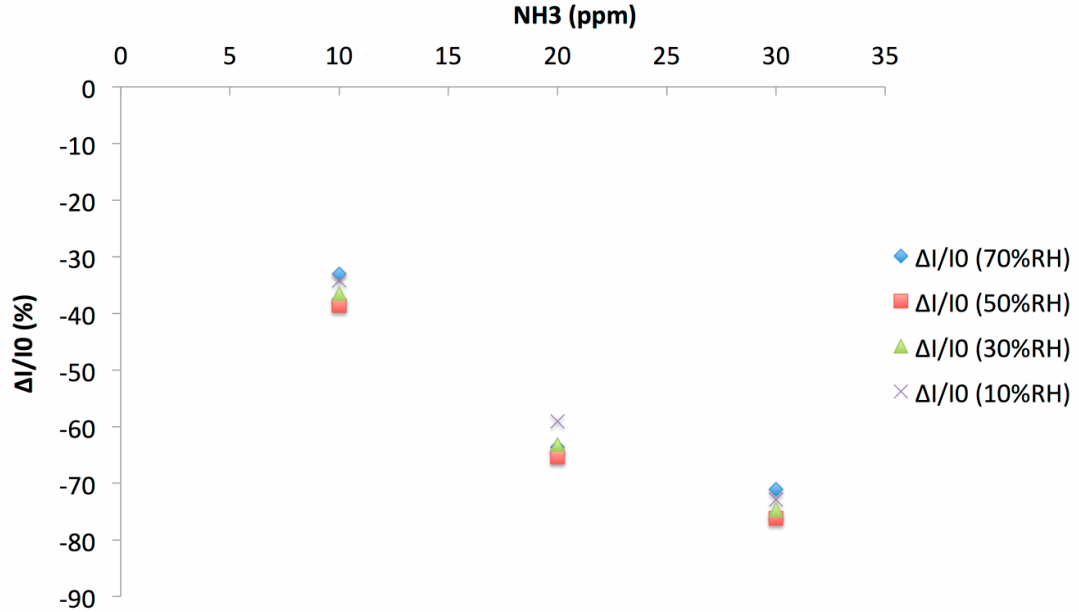
) of a (PANI/CuTsPc) device (E5) as a function of the 0 20